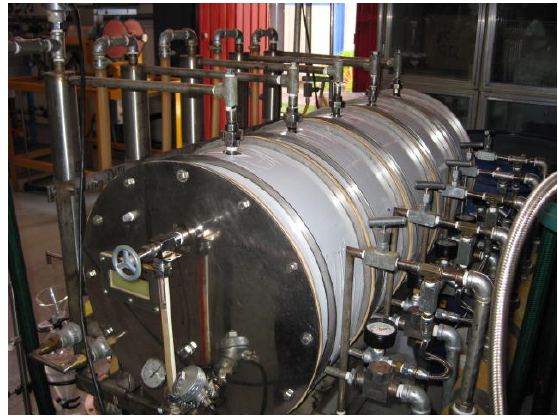
Figure 2. Multifunctional distillation prototype.